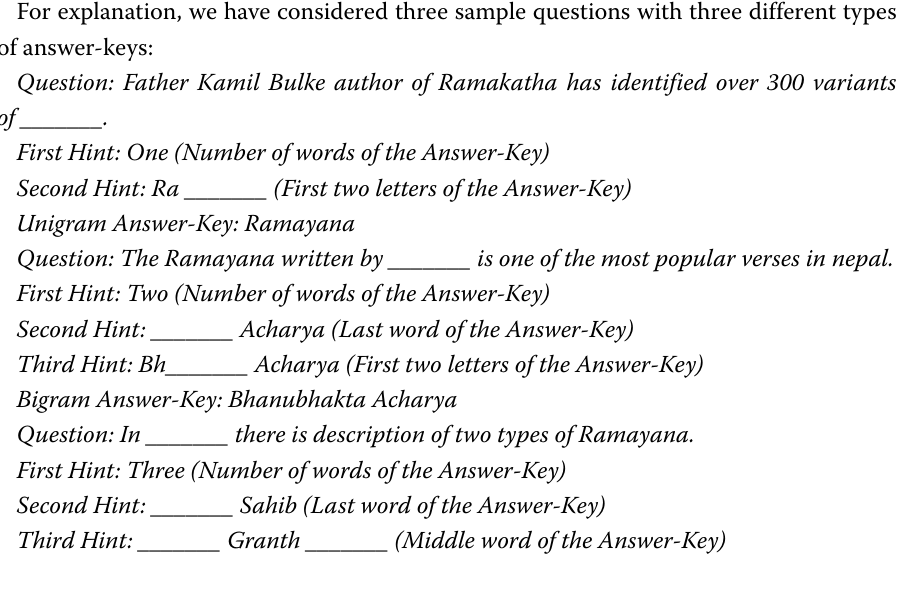
Table 4 Accuracy of answer-key identification No. of